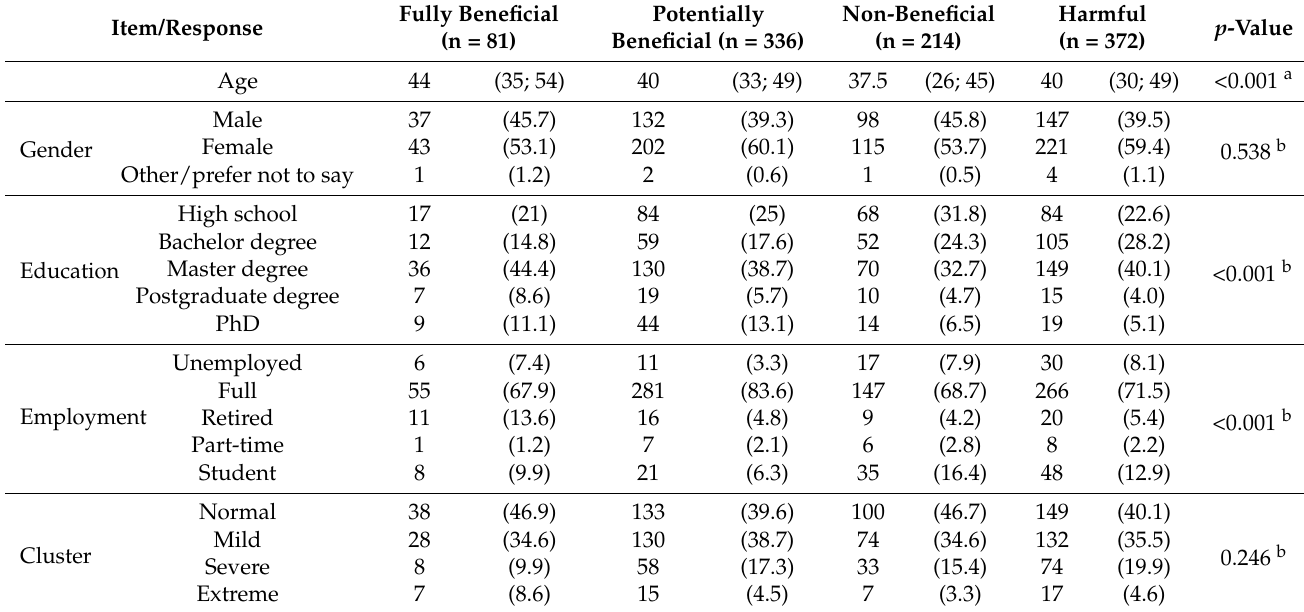
Table 5. Distributions of sociodemographic variables and clusters regarding the attitudes toward COVID-19